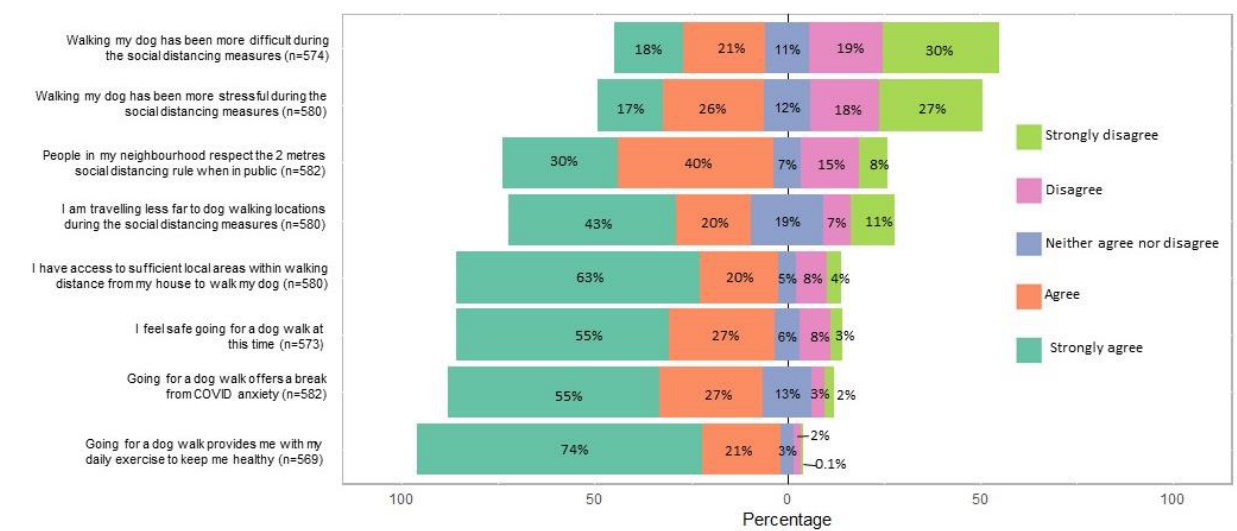
Figure 4. Summary of questions regarding experiences of and attitudes towards dog walking during the COVID-19 pandemic lockdown.